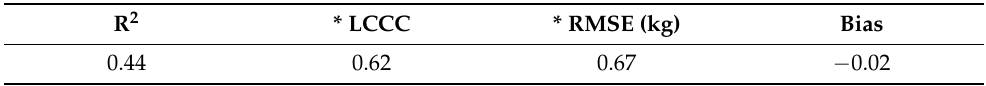
Table 5. Validated model statistics for machine learning model predicting live weight change of breeding cows from vegetation indices, date, and rainfall under extensive conditions.